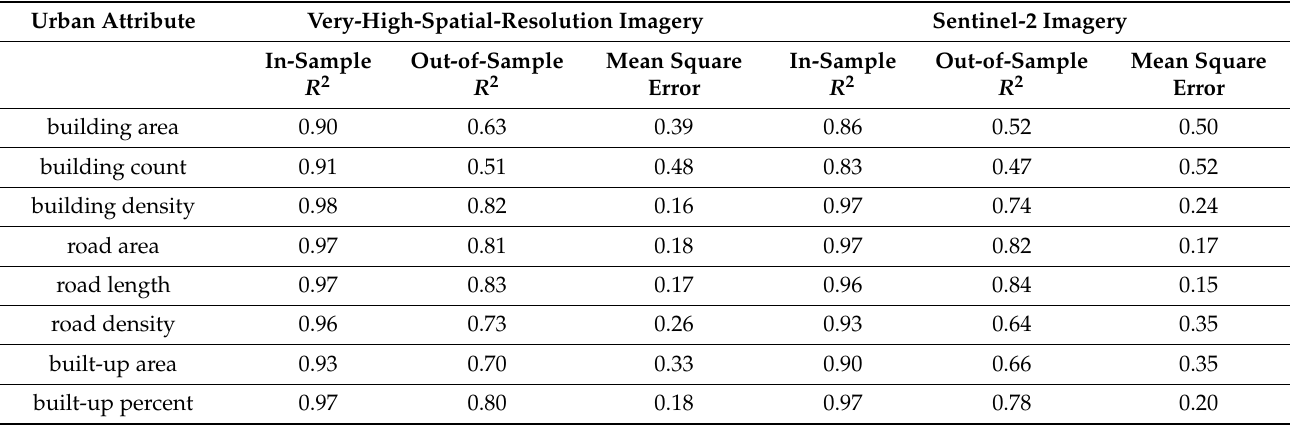
Table 8. R 2 and mean square error values for urban attributes using random forest models at different spatial resolutions for Sri Lanka (192 Grama Niladhari Divisions). Urban